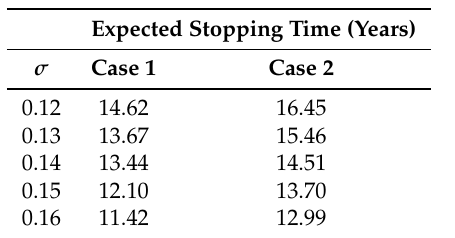
Table 4. Expected stopping times by level of market volatility for case 1 and case 2 agents aged 65, in the healthy state, and with total wealth of 10 Y —and other parameters as given in Table 1. Increasing market volatility results in shorter stopping times, as agents shy away from the riskier environment. The situation illustrated is for agents with risk aversion of γ = − 0.5, where case 2 agents are less conservative than case 1 agents. With more risk averse agents, this boldness of agents with bequest motives over those without is reversed.